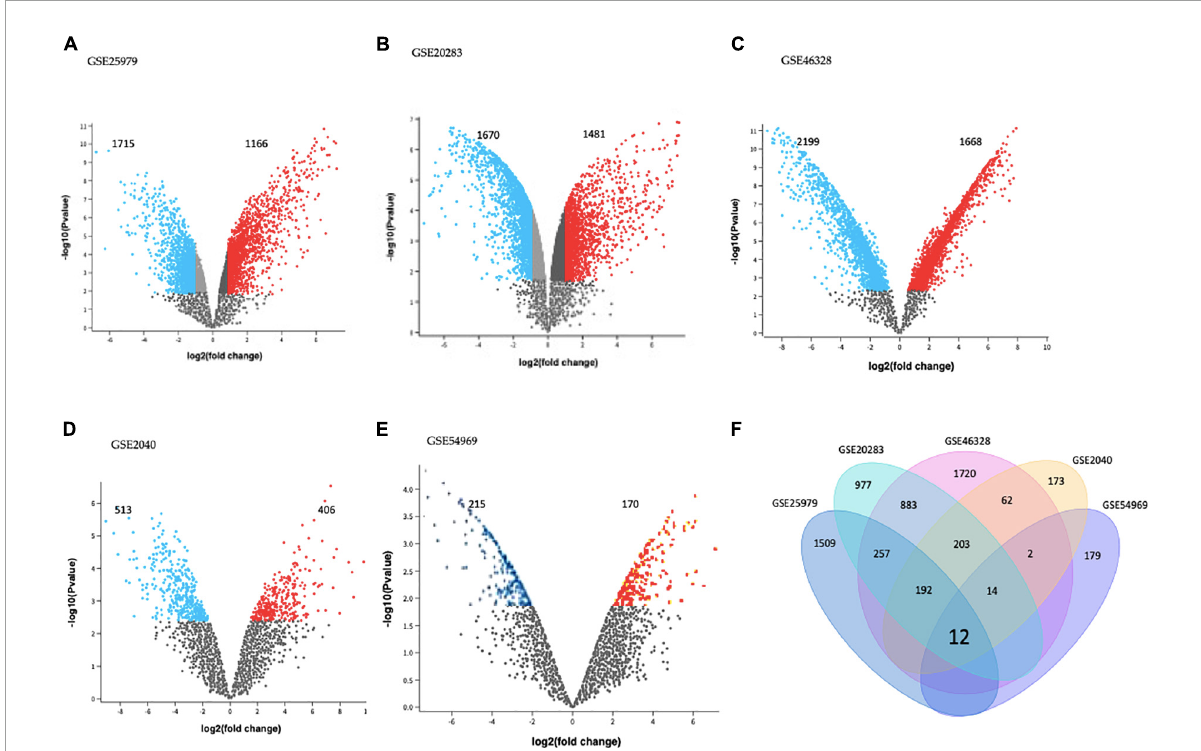
FIGURE1 Differentially expressed genes (DEGs) on (A) GSE25979, (B) GSE20283, (C) GSE46328, (D) GSE2040, and (E) GSE54969 datasets. GEO2R online tool was used to identify DEGs for each dataset with | log 2 FC| > 1.0 and adjusted p -value < 0.05; red dots and blue dots represents the significantly down-regulated and up-regulated DEGs on EPCs, respectively. (F) Common DEGs before meta-analysis, by simple crossing each dataset, visualized through a Venn diagram. Twelve genes were dysregulated with the intersection of the five